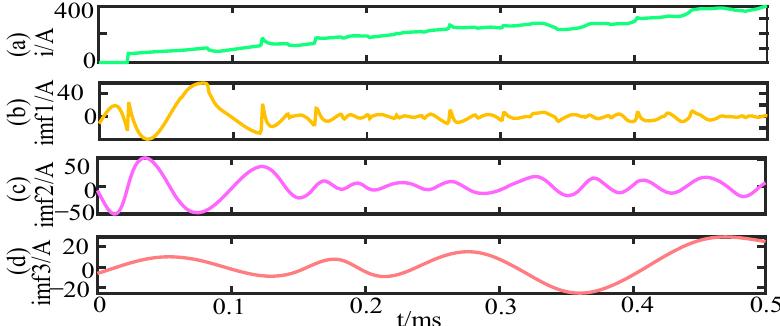
Figure 5. Original fault signal and IMF component.